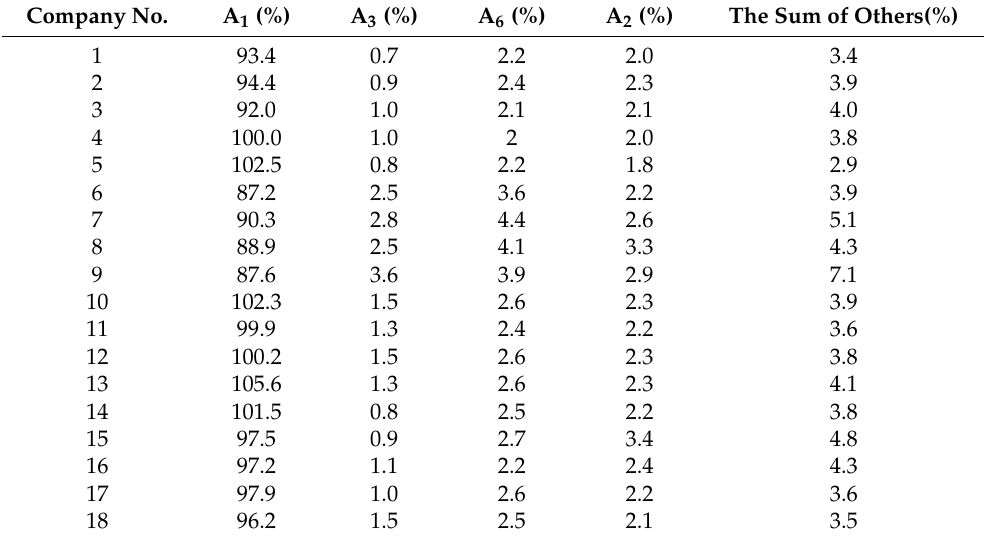
Table 5. Relative contents of components in midecamycin tablets from different companies. Company